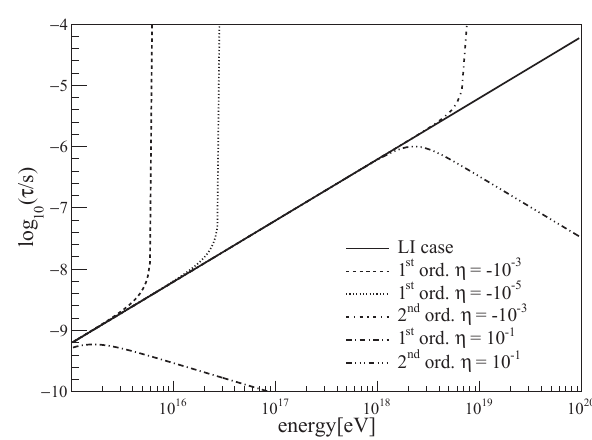
Figure 4. Neutral pion mean lifetime as a function of energy for the Lorentz invariant case and for di ff erent strengths of LIV. Figure from